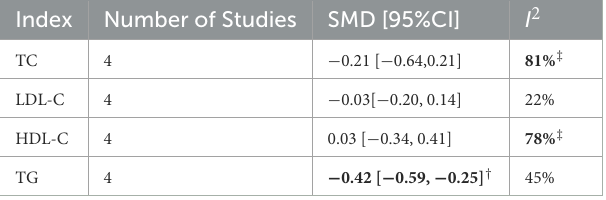
TABLE 2 Results of meta-analysis in five included